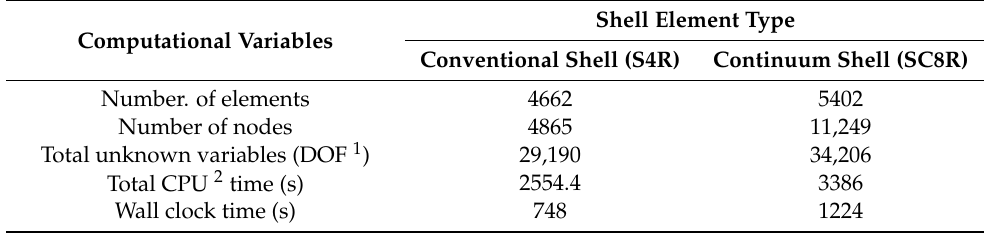
Table 2. Comparison of the computational parameters used for the FE simulation of the single-cell model under tension with conventional and continuum shell elements.